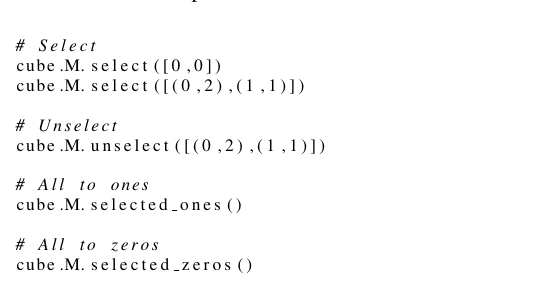
Figure 10. Different selection methods for MaskAccessor.